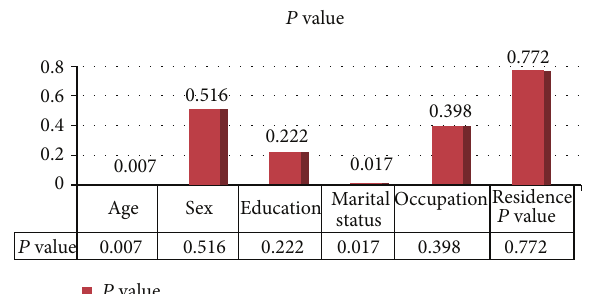
Figure 4: The association between adherence and sociodemo- graphic characteristics, Adama, Ethiopia,